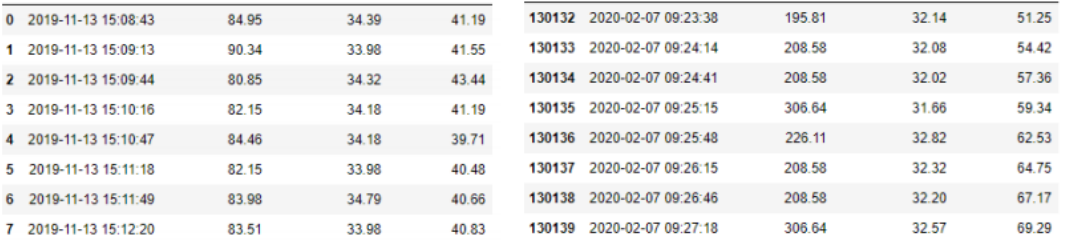
Figure 13. Imported Data presentation in